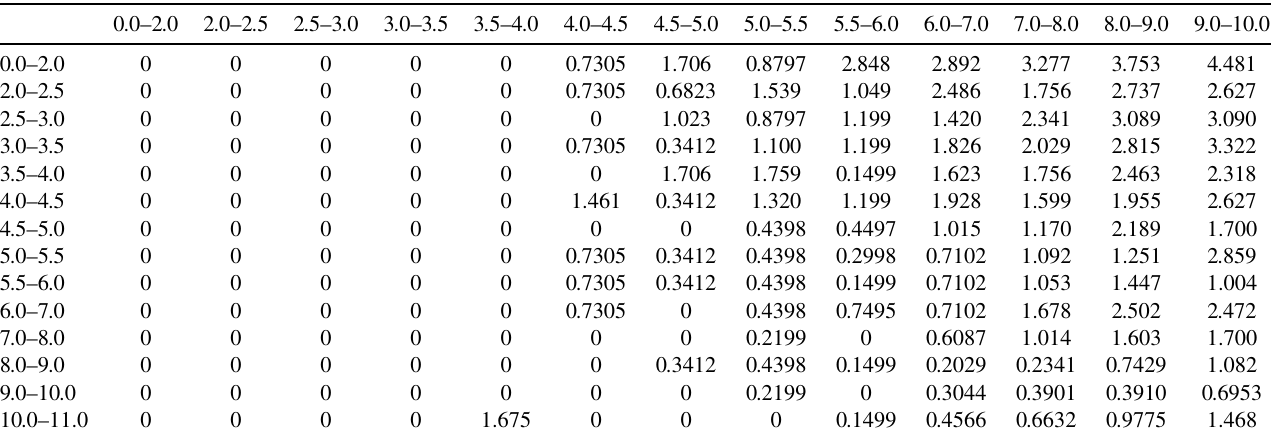
TABLE XVI. (cid:4) þ background from (cid:3) (cid:5) CC events (all values (cid:2) 10 (cid:1) 4 ).